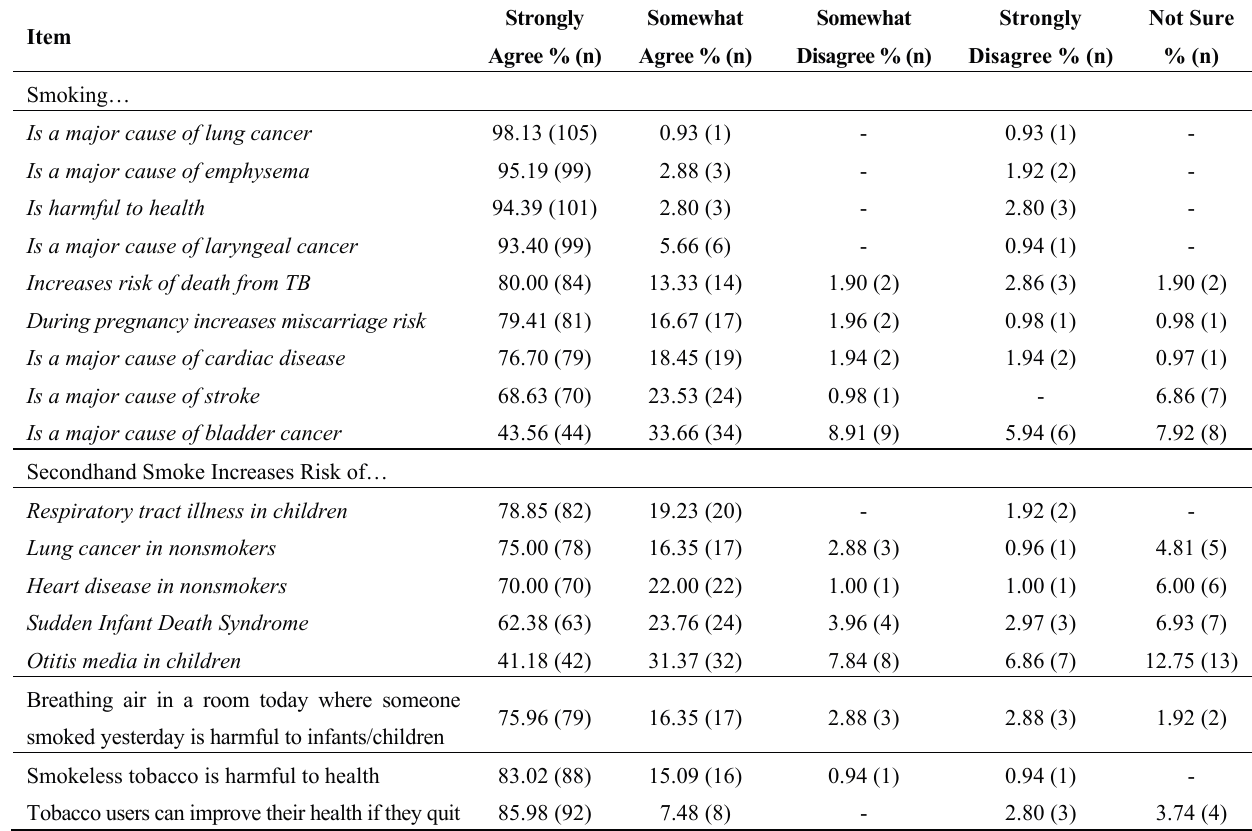
Table 2. Health care workers’ knowledge of the health effects of smoking, secondhand smoke, and smokeless tobacco.